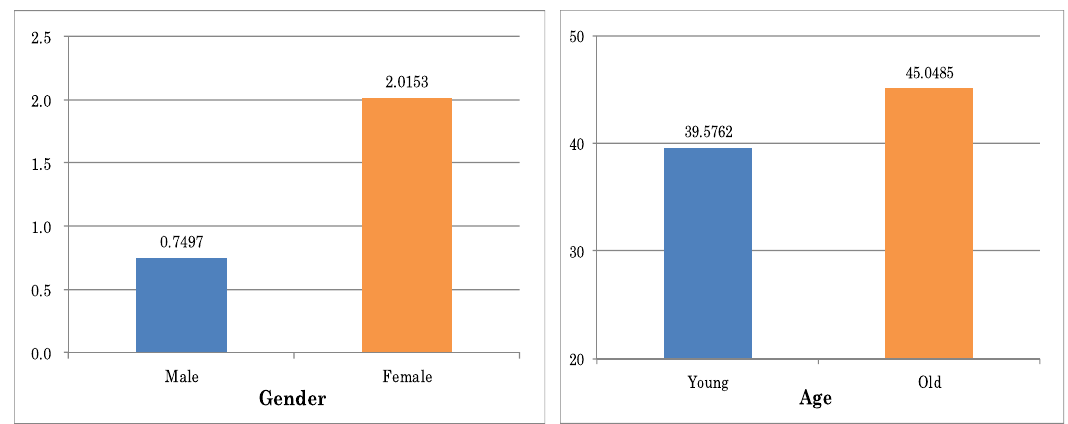
Fig. 1 Investor gender/age and referrer-investor relationships. The left-hand graph illustrates how referrers ’ gender affects investors ’ gender (the odds of being a female) and the right-hand graph illustrates how referrers ’ age affects investors ’ age. The left-hand graph is based on odds ratios and the right-hand graph is based on OLS results.